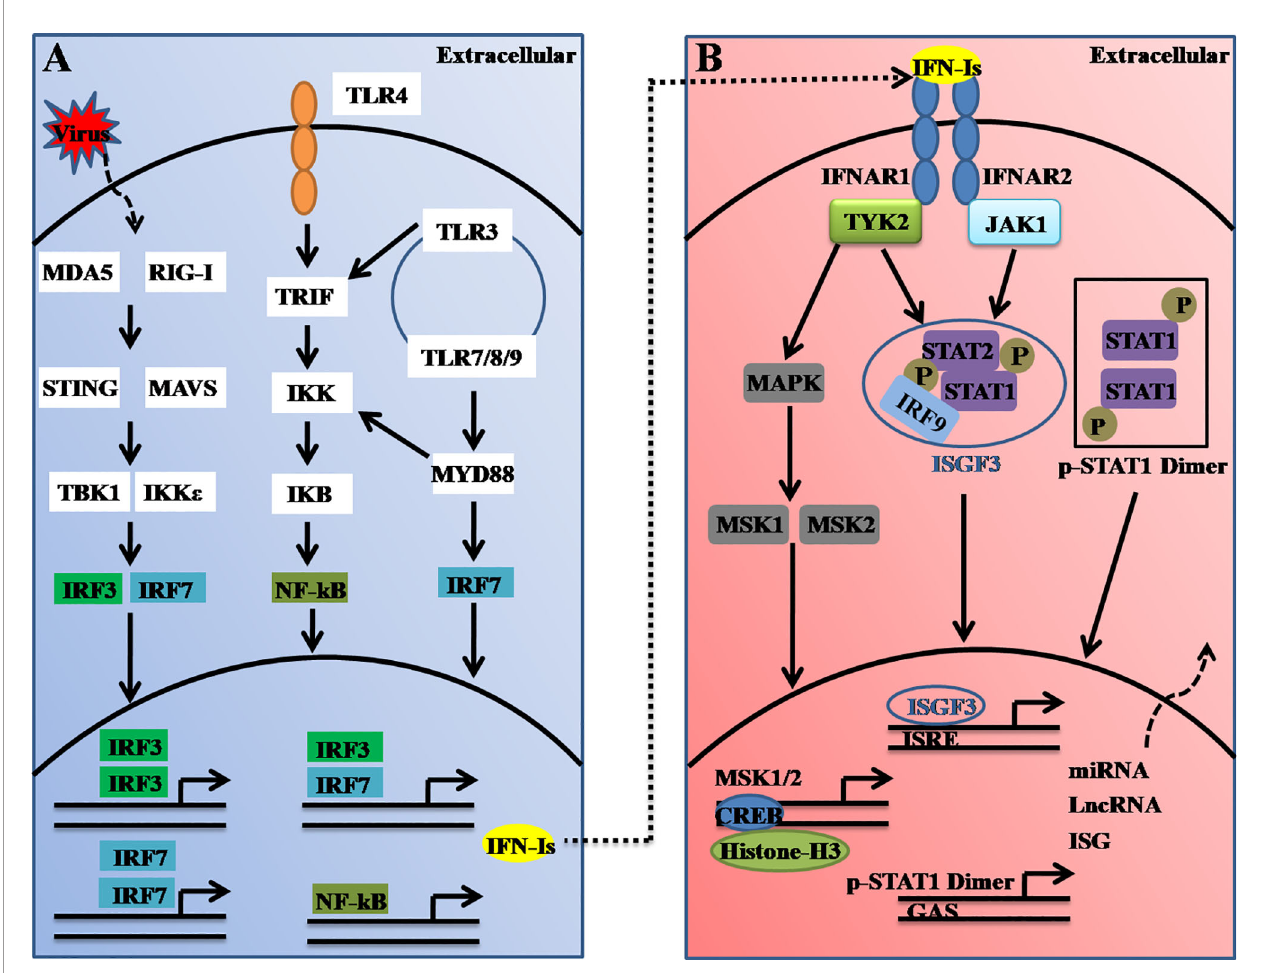
FIGURE 1 | Schematic illustration of type I interferon (IFN-I) induction and receptor signaling pathways. (A) Type-I IFNs are induced upon virus nucleic acid recognition by a variety of PRRs, including TLRs and cytosolic nucleic acid sensors. The activation of PRRs causes the nuclear translocation of IRFs or NF- k B, which bind to the promoter region of IFN-Is and thus induce their transcription. IRF3- and IRF7-mediated IFN-I production could be regulated by STING ( via cGAS), RIG-I, MDA5, TLR3, and TLR4 (through TRIF), whereas the ligand engagement of TLR7/8 and TLR9 activates IRF7 via MyD88. (B) Secreted interferons bind to the IFNAR complex composed of IFNAR1 and IFNAR2, which causes cross-phosphorylation of JAK1 and TYK2 and further activation of STAT homo/heterodimers to control distinct expression pro fi les. ISGF3, which comprise of STAT1, STAT2, and IRF9, binds to the IFN-stimulated response element (ISRE). TYK2 activates MAPK and MSK1/2. Nuclear MSK1/2 further phosphorylates CREB and induces the transcriptional induction of hundreds of genes or noncoding